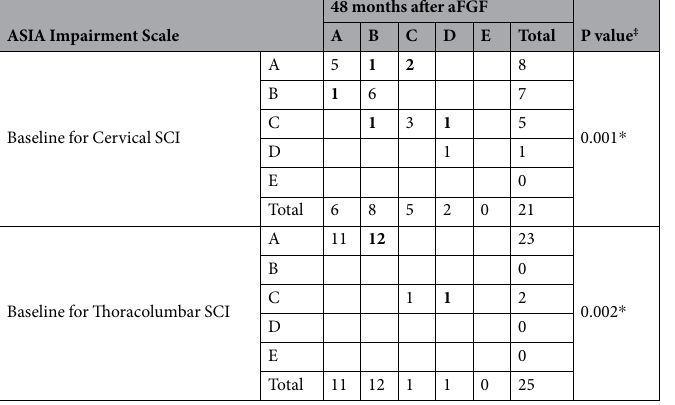
Table 2. Comparison of ASIA Impairment Scale between baseline and 48 months postoperatively in each group † . † Values in bold face represent the numbers of patients whose ASIA Impairment Scales improved from the baseline. ‡ Based on Pearson Chi-Square Test. * Significant at p <